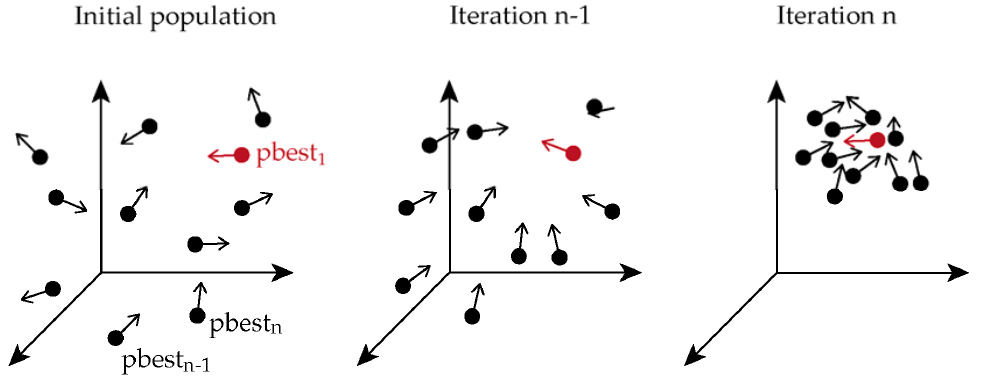
Figure 5. Particle following in PSO.